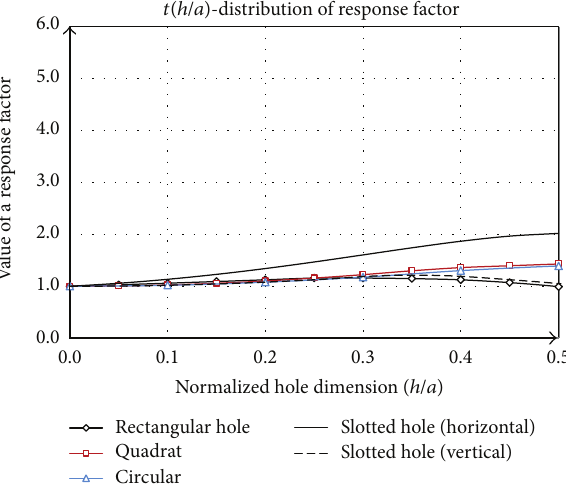
Figure 12: Change of coefficient 𝜆 in relation to the parameter (ℎ/𝑎) for the considered hole. Figure 13: Sensitivity factor 𝑡 as a function of the (ℎ/𝑎) for the holes of the considered